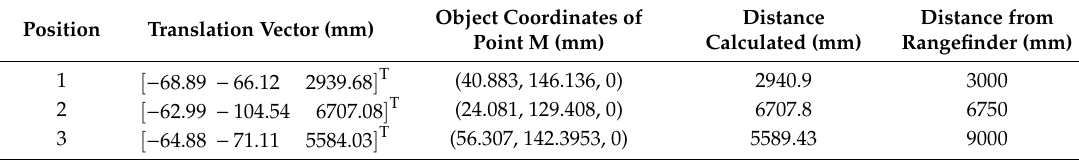
Table 4. The distance